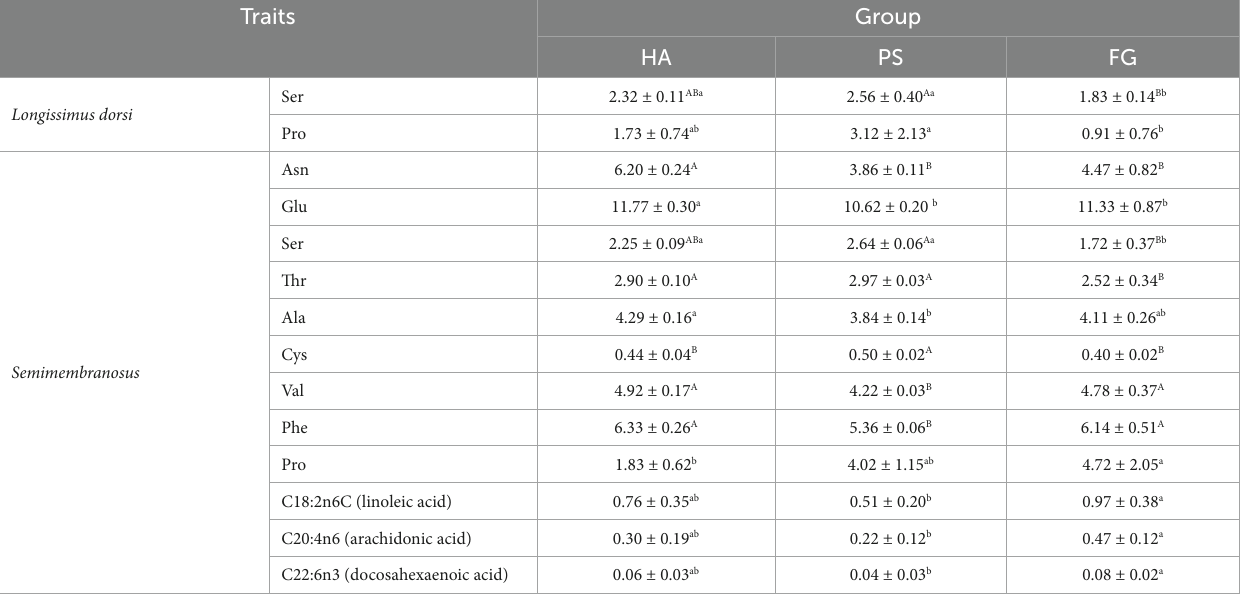
TABLE 2 Significantly changed amino acids (g/100 g dry matter) and fatty acids (g/100 g dry matter) of goat meat under different forage treatments. Traits